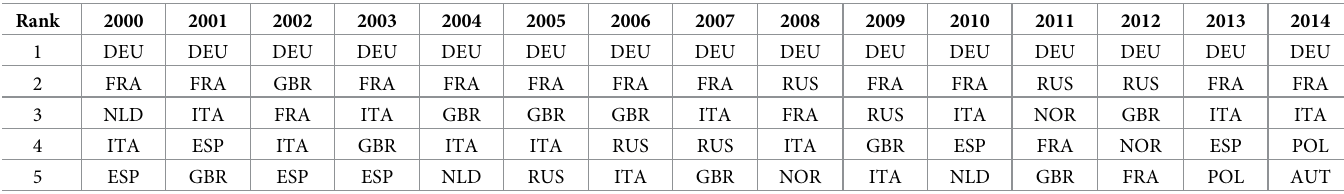
Table 7. Five-highest circulated countries in European community.